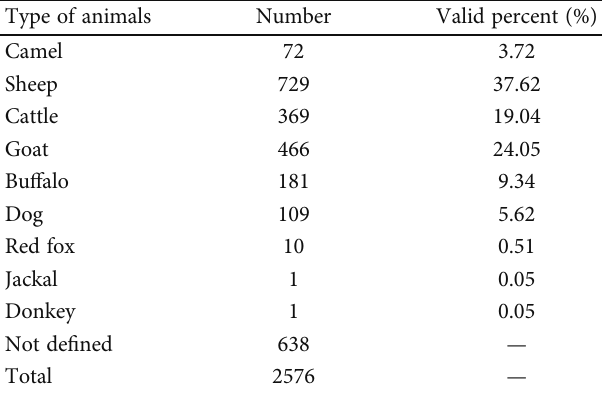
Table 2: Type of animals percent in 28 studies included in the